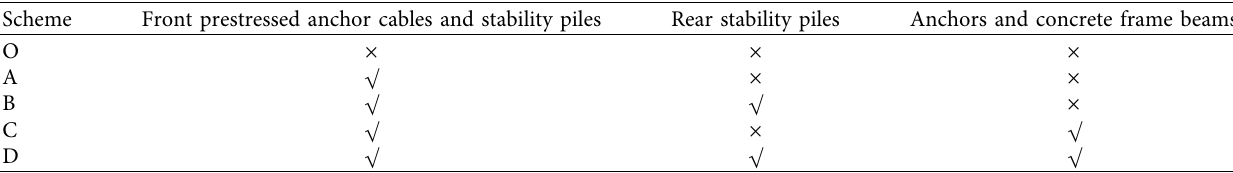
Table 3: Reinforcement schemes.